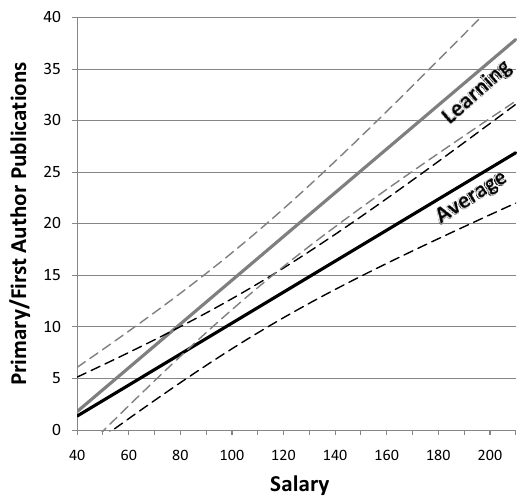
FIG. 2. Regression lines predicting primary and/or first-author publications with increasing salary in thousands while controlling for gender, race and/or ethnicity, field, current position, and years in current position. Dashed lines represent 95% confidence